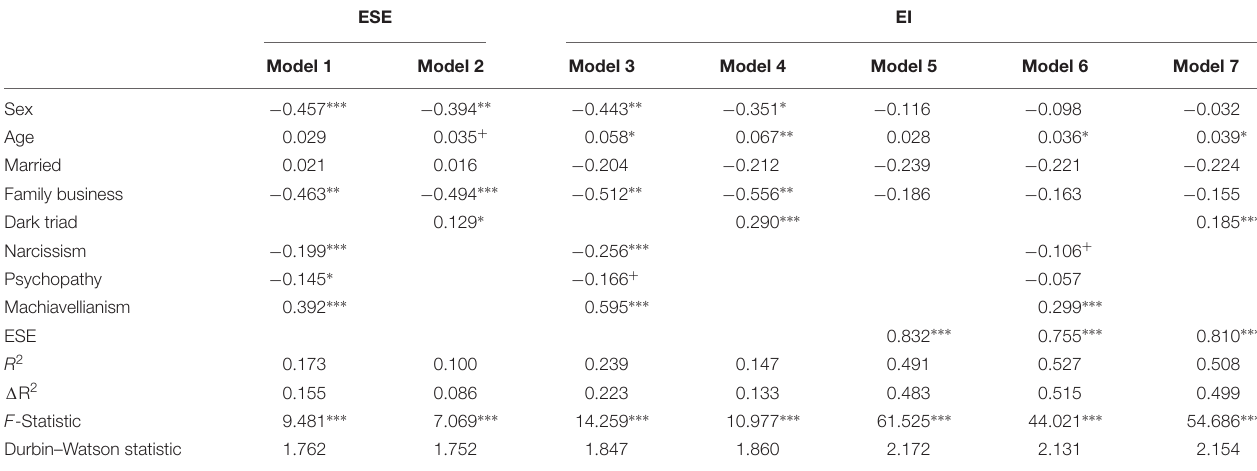
TABLE 3 | Results of multiple regression analysis.